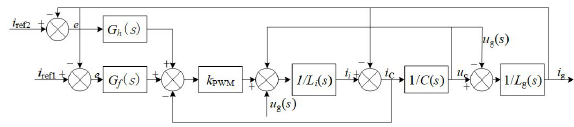
Fig. 3. Bode diagram of quasi proportional resonance controller.